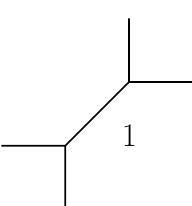
Figure 13. The simplest example of gluing of two b gl (1) Kac-Moody